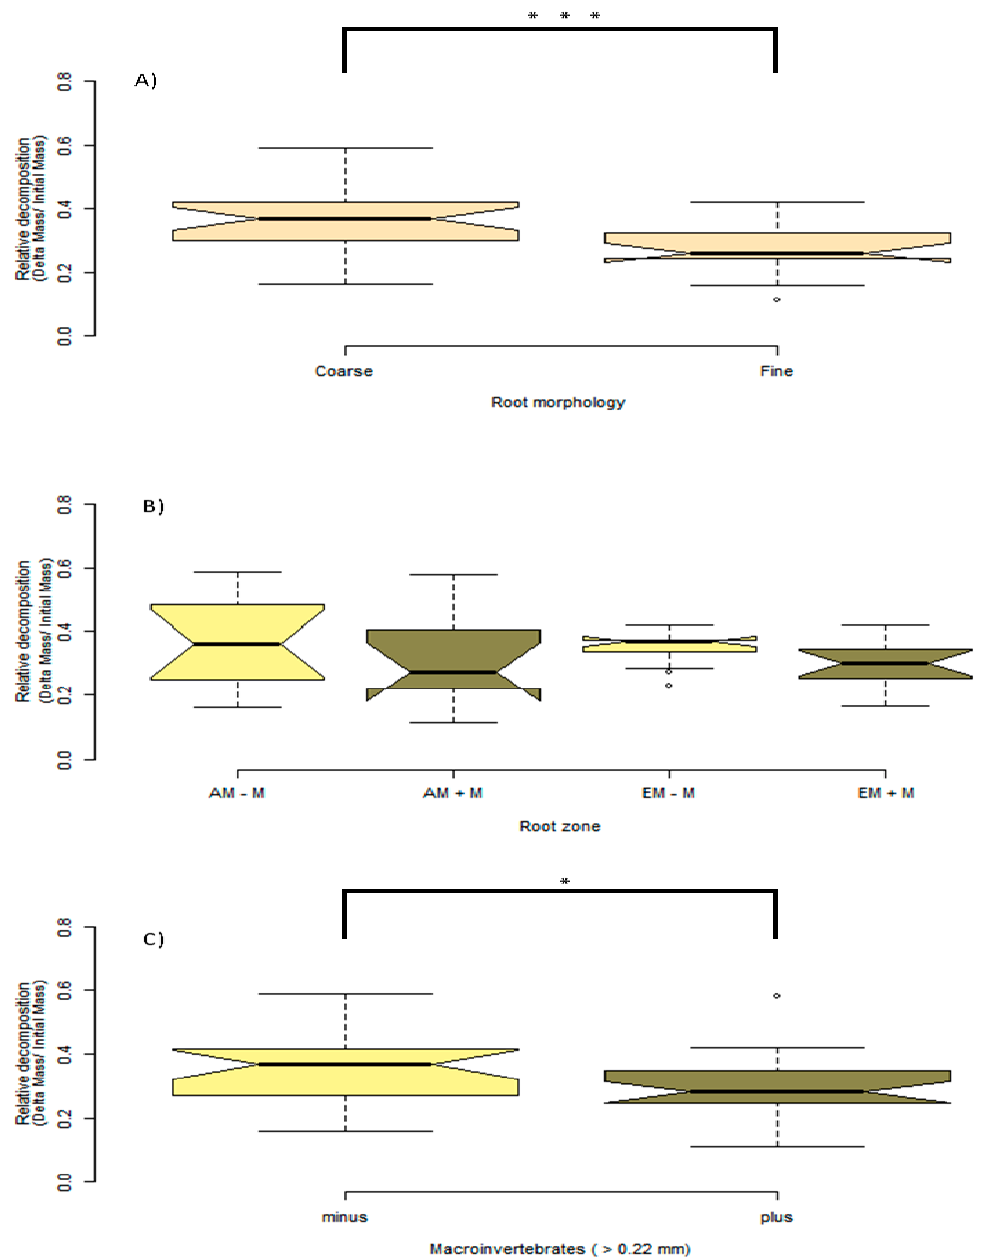
Figure 6. Provided here are boxplots showing the outcome of experimental factors on wood decom- position. The notches in each boxplot represent 95% CI around the mean. The upper edge and lower edge of each boxplot is the 25% and 75% quartile, or the lower and upper median, which are the boundaries of the interquartile range (IQR). In addition, the boxplot whiskers represent 1.5 × IQR, and points beyond the whiskers are outliers. ( A ) Seen here are coarse versus fine root species, and coarse roots are defined as roots > 0.35-mm, and fine roots are defined as < 0.35-mm. ( B ) Root zone and macroinvertebrate effect on decomposition. Light-khaki-colored boxplots represent macroin- vertebrate exclusion ( − M); dark-khaki-colored boxplots represent non-macroinvertebrate exclusion (+M). ( C ) The main effect of macroinvertebrate exclusion. Significance: * p < 0.05; *** p < 0.001